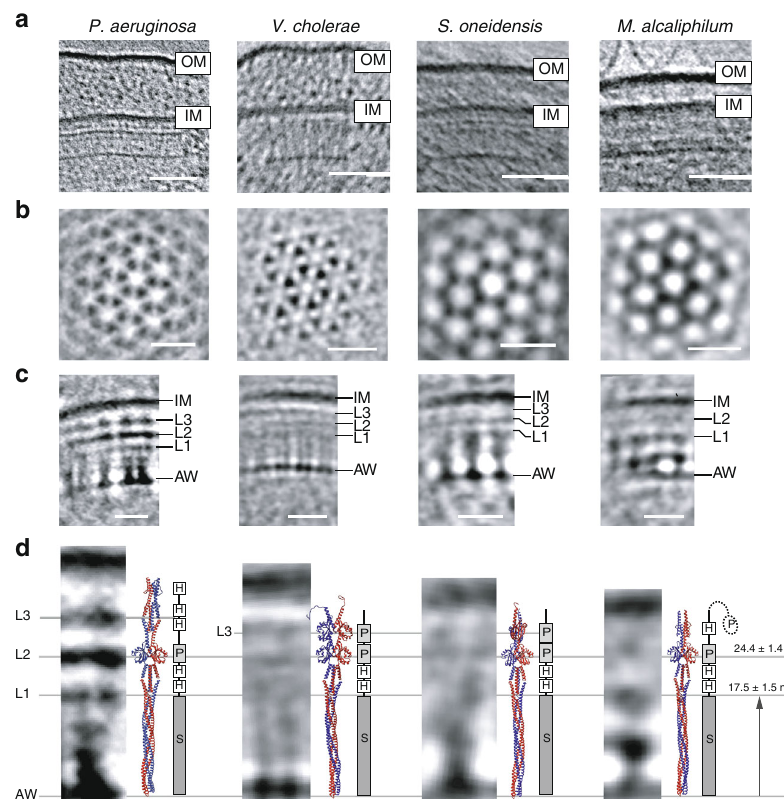
Fig. 2 Structural analysis of F7 chemotaxis arrays. a Side-view of F7 chemotaxis arrays (scale bar: 50 nm) relative to the inner membrane (IM) and outer membrane (OM). b Top-view of a sub-tomogram average at the CheA/CheW layer reveals that F7 arrays have the typical hexagonal packing of receptors with ~12 nm spacing (scale bar: 20 nm). c Side view of the sub-tomogram averages. Several density layers (L1 – L3) are present between the inner membrane and the CheA/CheW layer (AW) (scale bar: 20 nm). d A comparison of the side-views from the sub-tomogram averages with homology models of chemoreceptors (to scale). The presence of PAS domains in the receptor structures consistently correlate with L2 layer in all organisms and the L3 layer in V. cholerae and S. oneidensis . The box diagram shows the PFAM protein domains of each receptor: PAS (P), HAMP (H), and MCPsignal (S). The distance measurements were taken using 1D average pro fi le and the uncertainty reported as described in the Methods